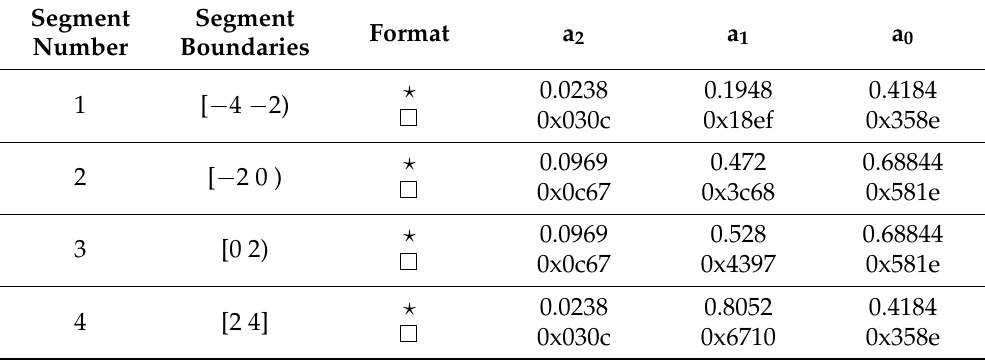
Table 8. Floating-point and fixed-point coefficients for implementing Softplus AF in